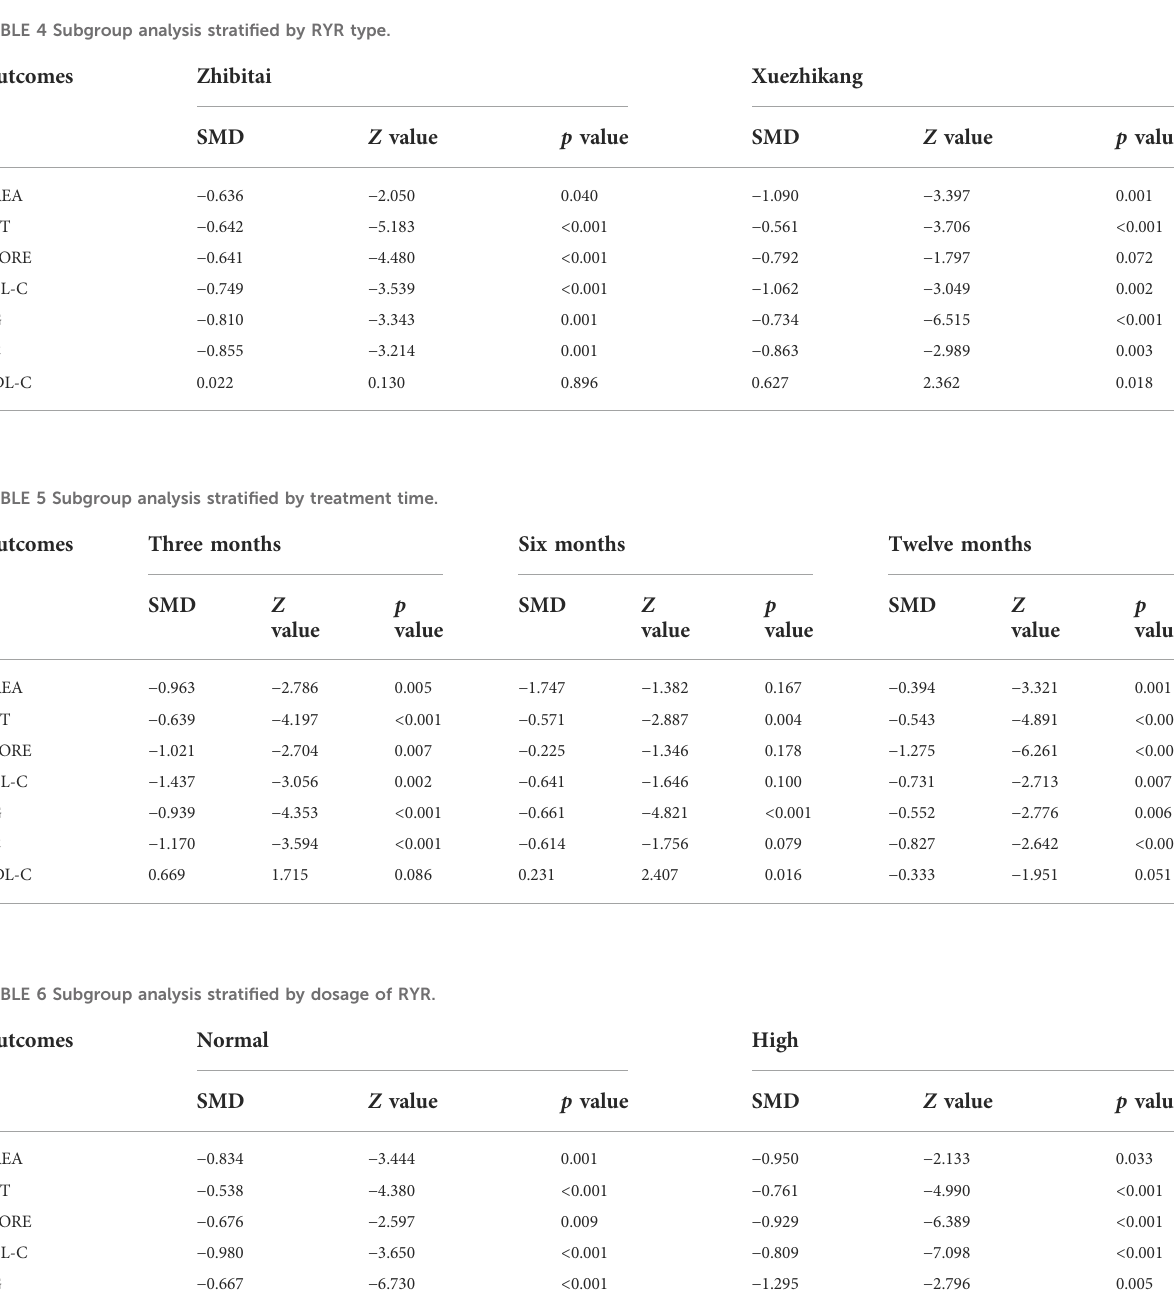
TABLE 4 Subgroup analysis strati fi ed by RYR type.